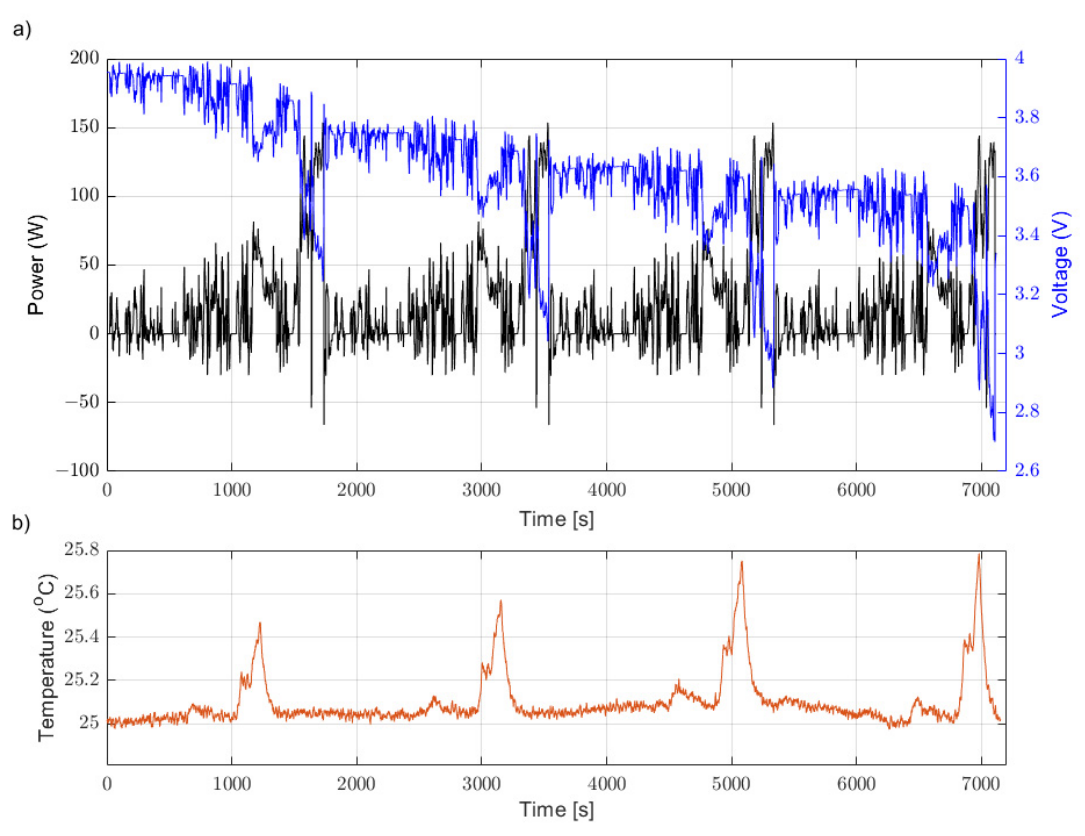
Figure 4. WLTP drive cycle, repeated twice, used to evaluate performance of each set of extracted ECM parameters at 25 °C in the ICP. ( a ) Power and Voltage data; ( b ) Temperature data.